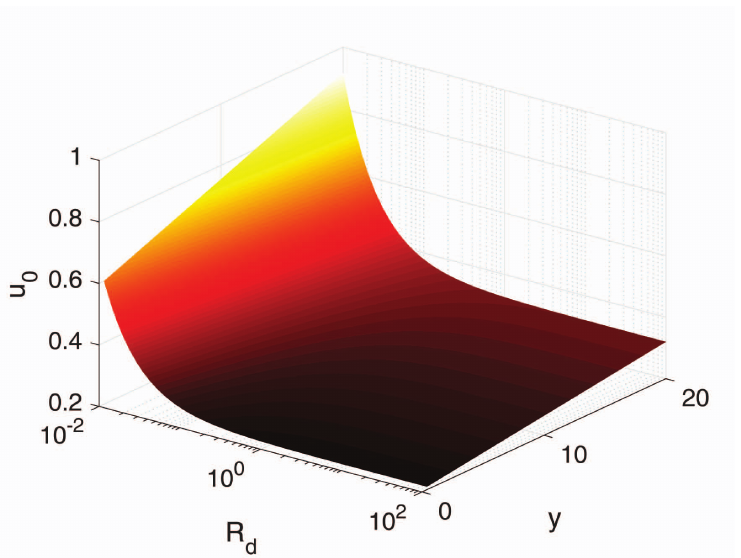
Figure 3. Variation of the equivalent control as R D and ¯ y vary. For “standard” loads the control increases linearly with the reference current.